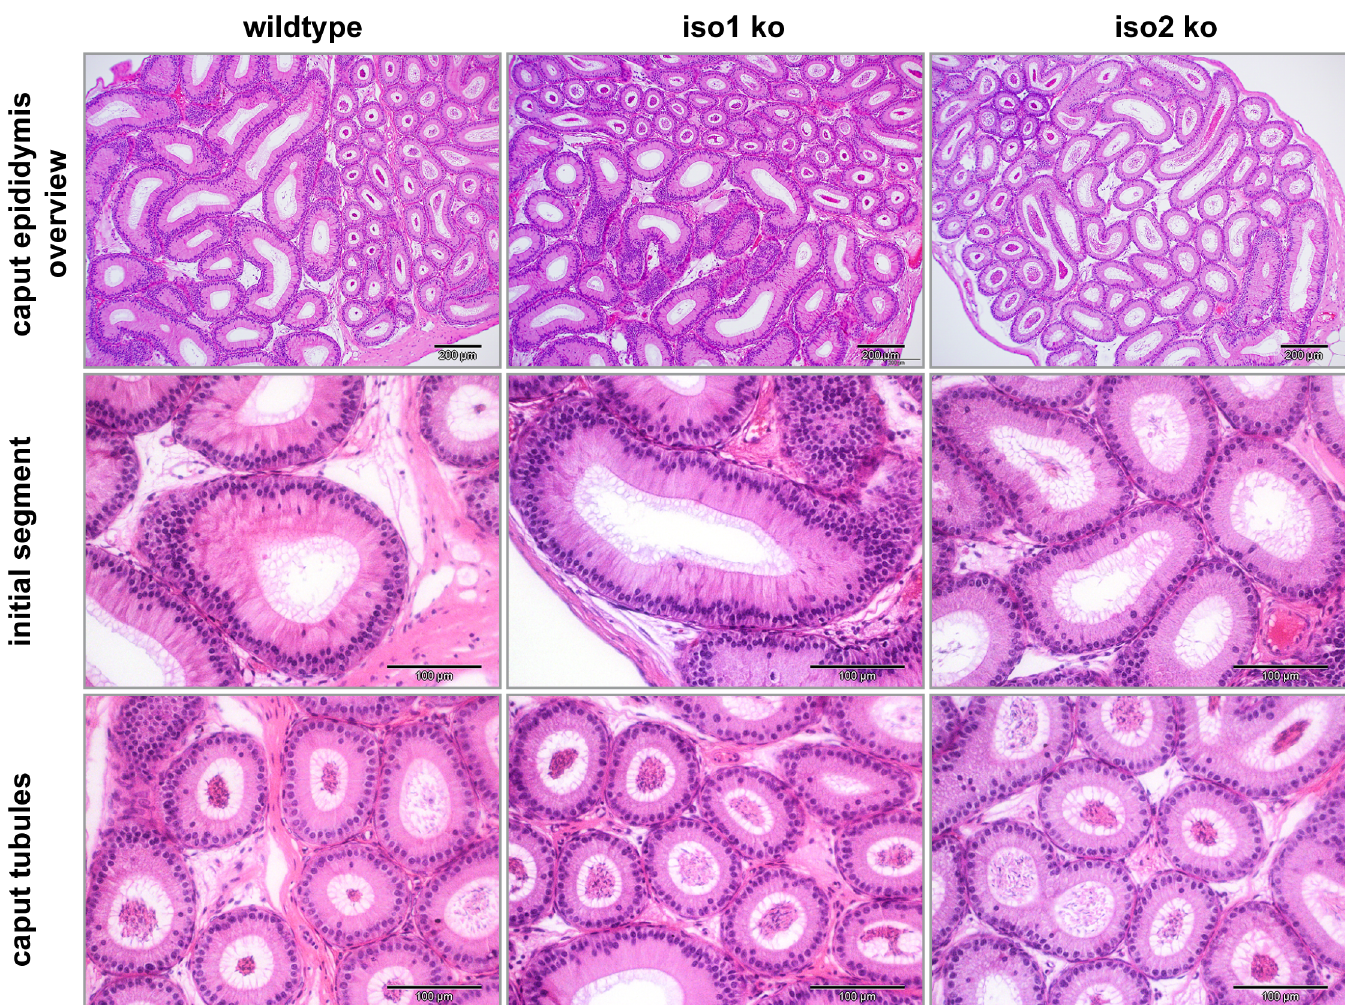
Fig 8. Epididymal vesicle formation is altered in ko animals. H&E stained sections showed normal histology of iso1 ko and iso2 ko epidiymises. (scale bars = 200 μ m (overview)/ 100 μ m (lower